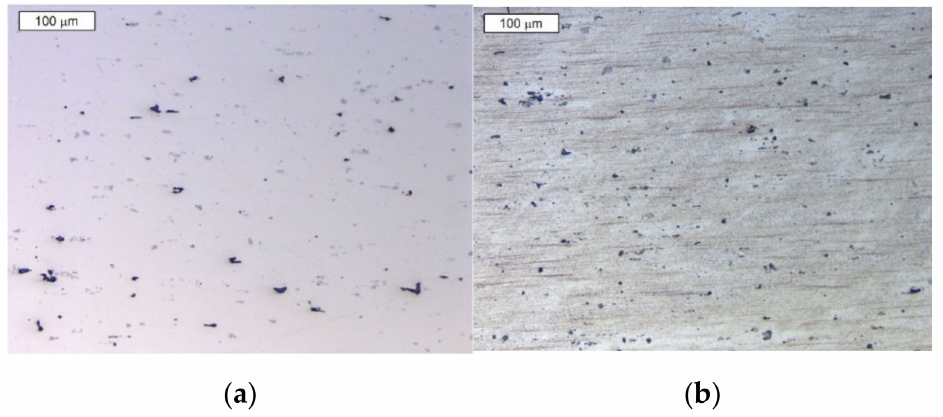
Figure 5. Microstructure of the alloy in the T6 state: ( a ) unetched state and ( b ) etched state. Light microscopy,